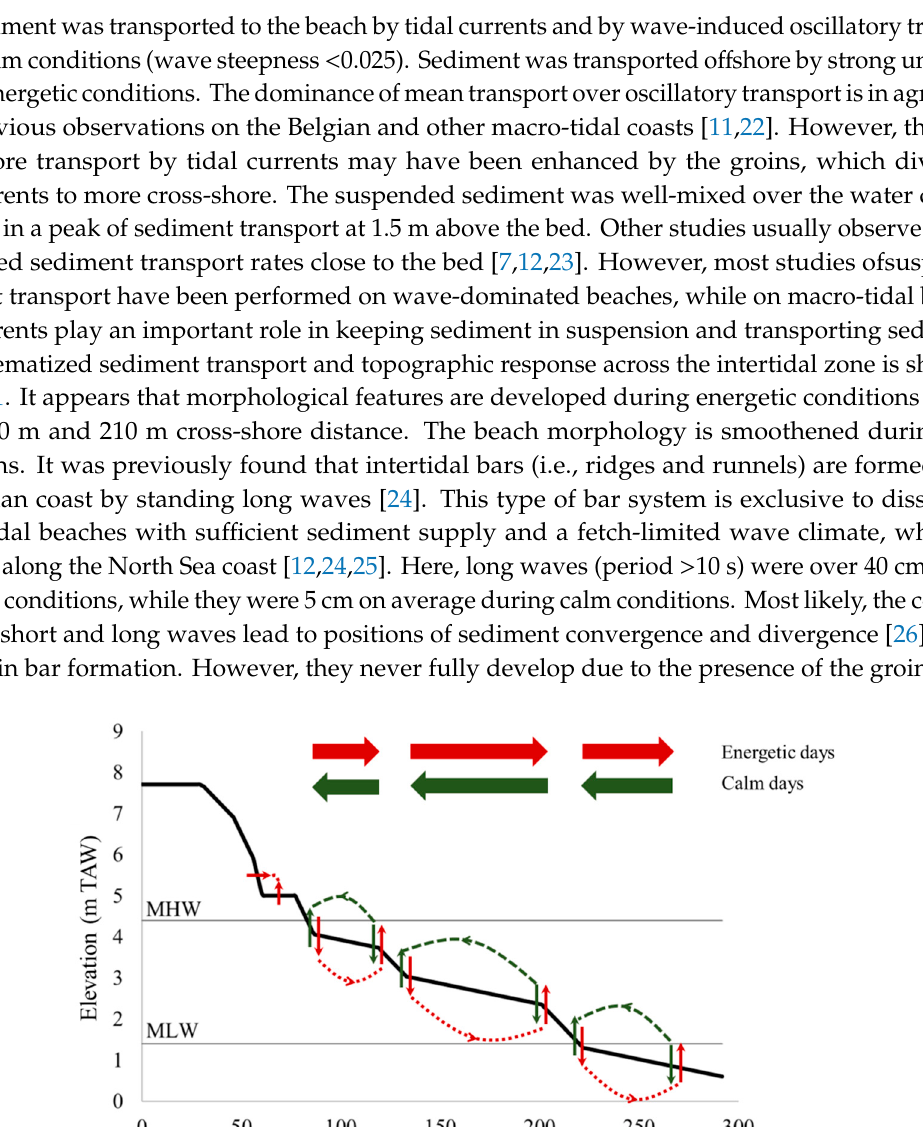
Figure 10. Beach slope (left = November, right = April) with zones of maximum erosion/accretion indicated for days when considerable offshore (left) or onshore (right) suspended sediment transport was measured by the frame.